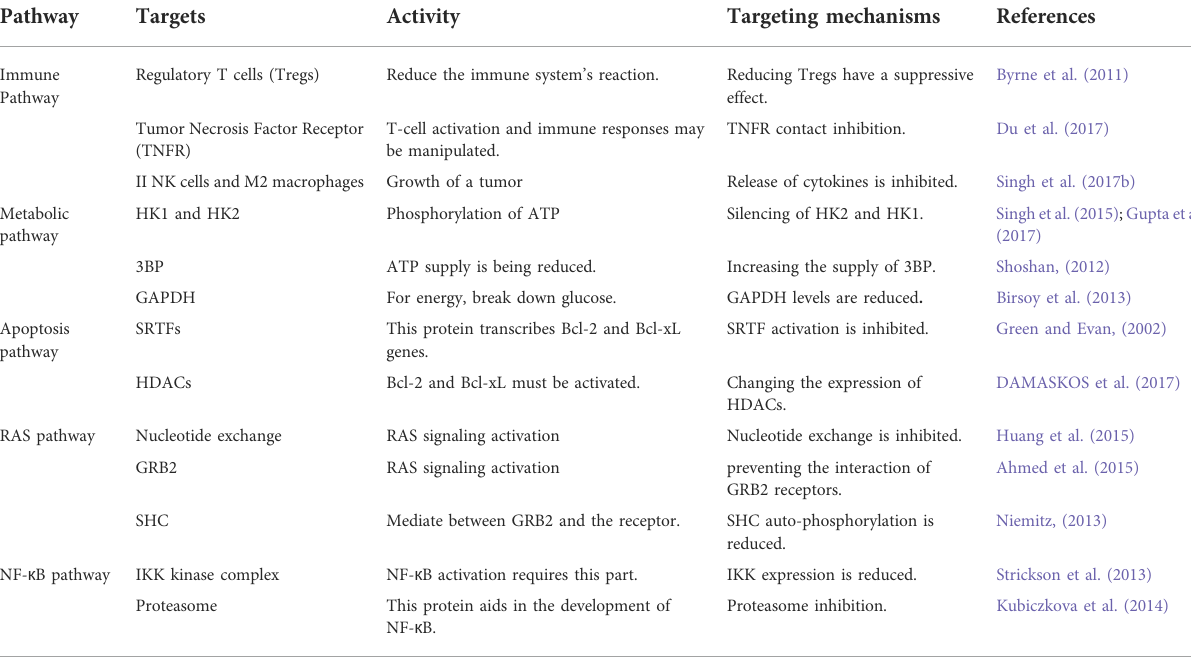
TABLE 1 Targets of common pathways implicated in cancer treatment with clinical action strategies (Singh and Shukla,